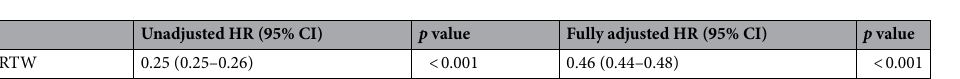
Figure 4. Kaplan–Meier curve for all-cause mortality categorized by all cancer stages. ( A ) all stages ( B ) stage 0; ( C ) stage 1; ( D ) stage 2; ( E ) stage 3; ( F ) stage 4.